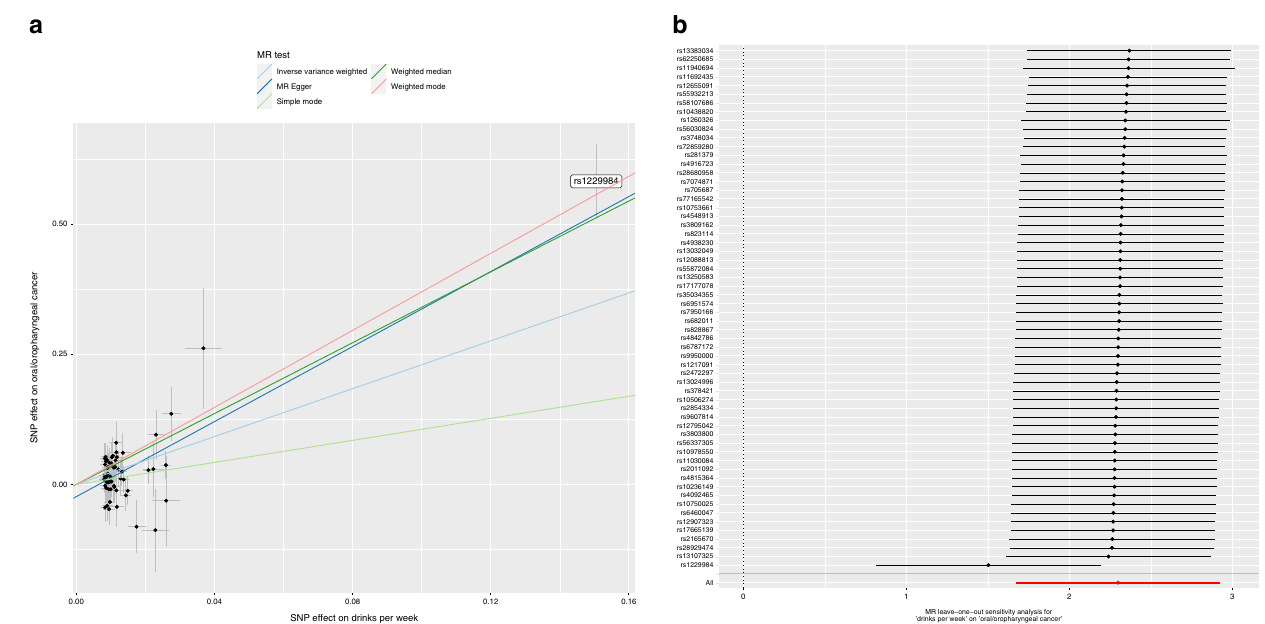
Fig. 1 Scatter and leave one out plots demonstrating in fl uential outliers in univariable MR of alcohol consumption and oral and oropharyngeal cancer risk. a Scatter plot showing ADH1B (rs1229984), an outlier single nucleotide polymorphism in the analysis of alcohol consumption (drinks per week, n = 941,280) and oral and oropharyngeal cancer risk ( n = 6034 cases and 6585 controls). b Leave one out plot again demonstrating the ADH1B (rs1229984) in fl uential outlier. Consistent evidence for a causal effect of alcohol on oral and oropharyngeal cancer risk was found even when this variant was excluded from the analysis. Effect estimates are reported per SD increase in the exposure and error bars represent 95% con fi dence intervals.